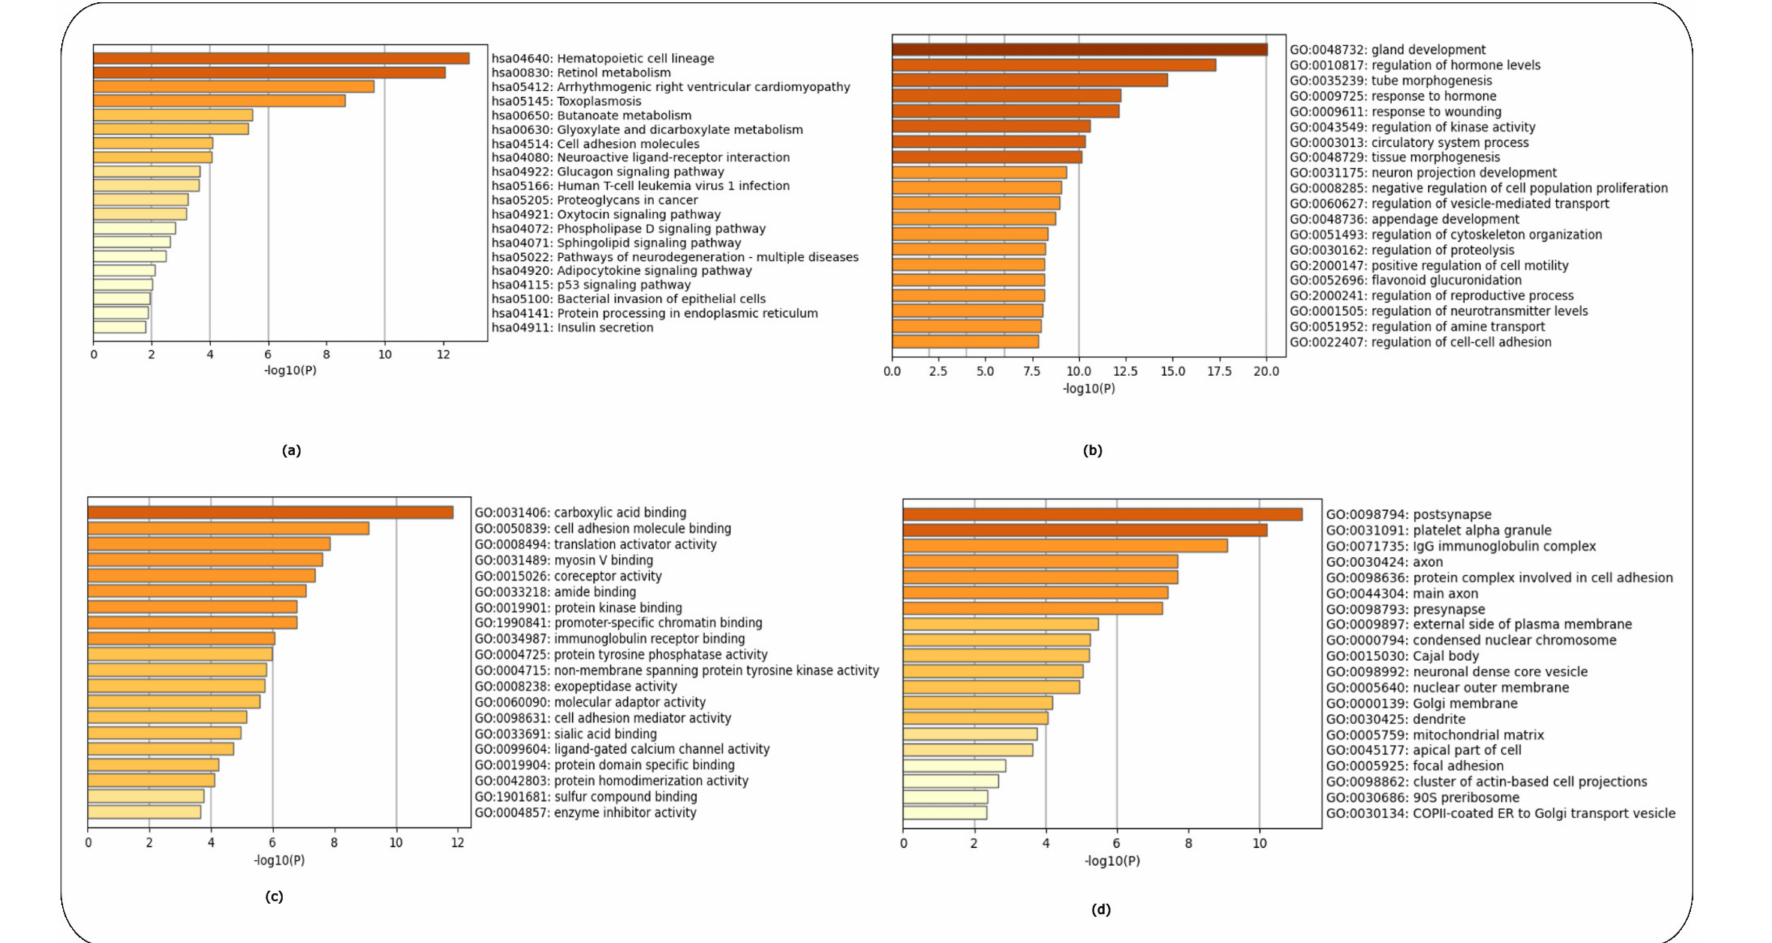
Figure 5. Enrichment analysis of controls versus HD patients using the KEGG and GO libraries in Metascape. ( a ) KEGG pathways, ( b ) GO Biological Process, ( c ) GO Molecular Function and ( d ) GO Cellular